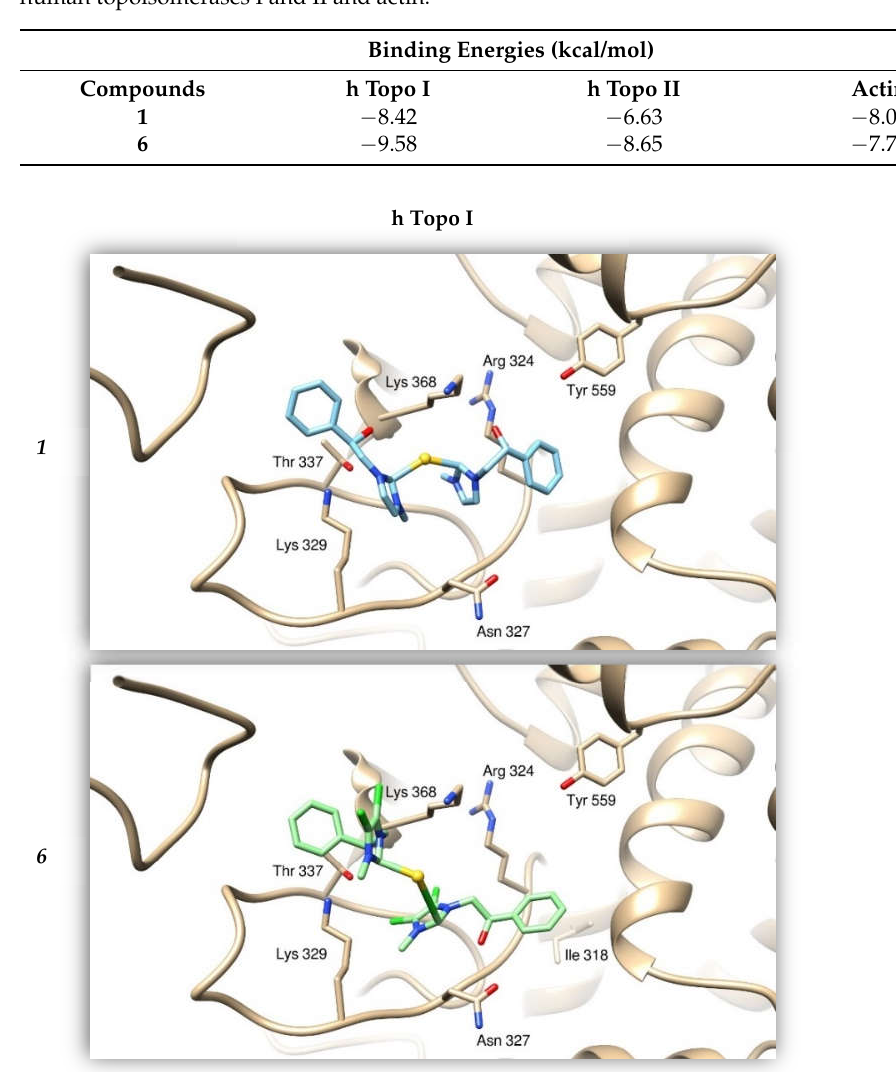
Table 4. Binding energies for both compounds 1 and 6 as resulting from in silico simulations, towards human topoisomerases I and II and actin.